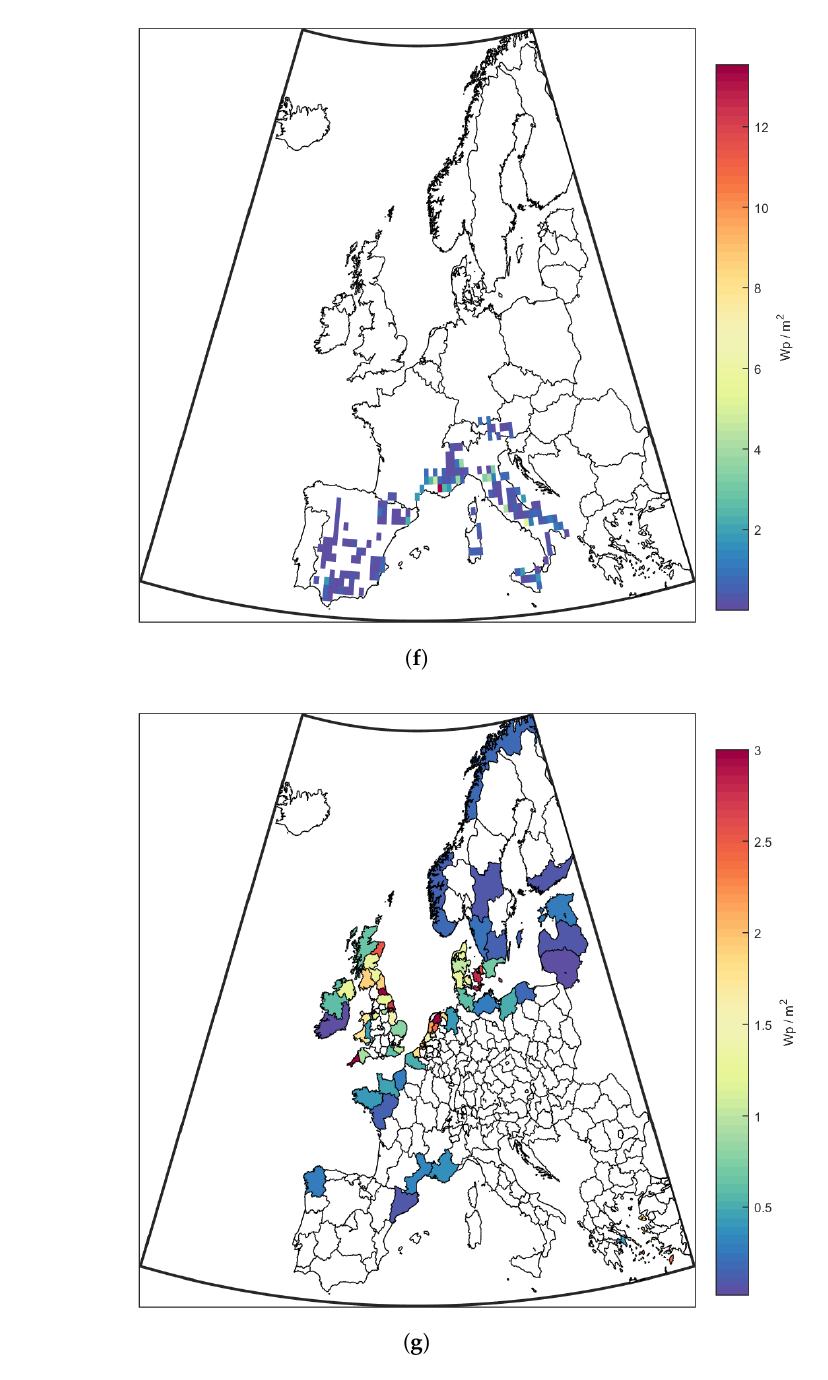
Figure 2. Model results for the solar net metering scenario including ( a ) the capacity of electricity generation investments, ( b ) the capacity of new transmission (GW p ) and storage (GWh) investments, ( c ) the electricity generated by generation type and year plus yearly electricity transmitted internationally and yearly energy transferred to storage, ( d ) the upper limit allowed by the model and the actual CO 2 emissions over time, ( e ) the installed capacity of distributed solar PV (CdTe), ( f ) the installed capacity of distributed solar PV (mono-Si), and ( g ) the installed capacity density of wind power. Note that the order of the legends for line and area plots corresponds to the order of the respective values in 2010 from top to bottom. Note also that the color of the regions/quadrants on map plots indicates the installed capacity density in the given region/quadrant where white signifies zero